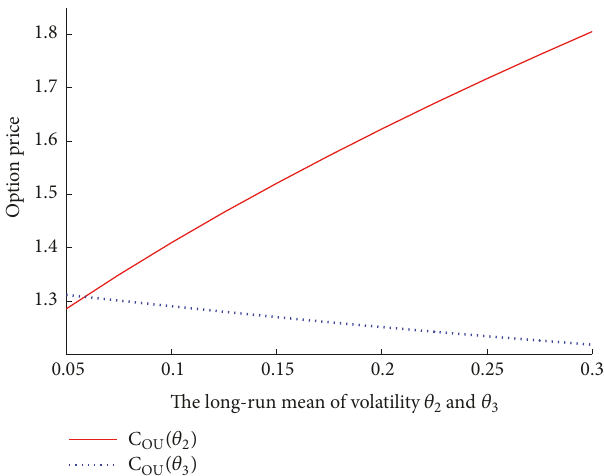
Figure 3: The effects of long-run means of stochastic volatility 𝜃 2 and 𝜃 3 on the vulnerable option